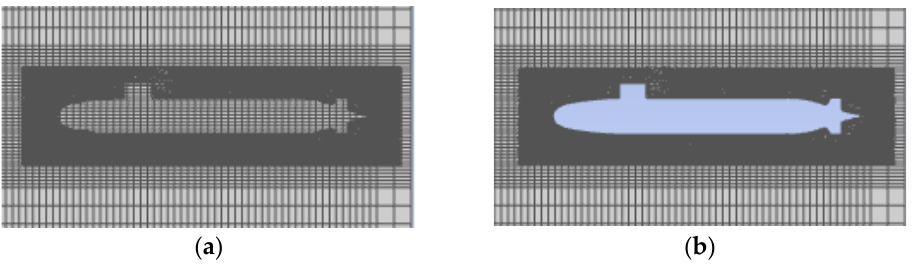
Figure 3. Submarine grids before and after burrowing. ( a ) Grid before burrowing and ( b ) Grid after burrowing.